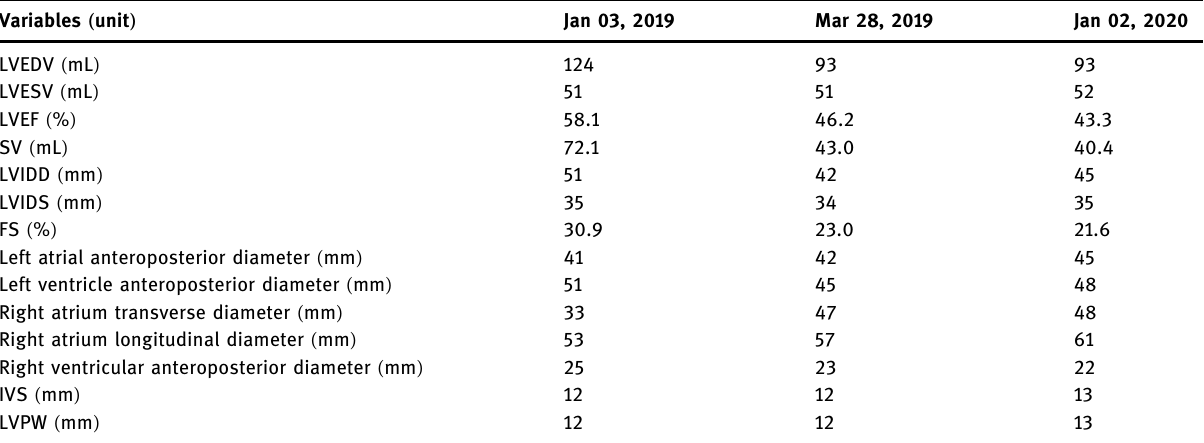
Table 2: Echocardiographic analysis results